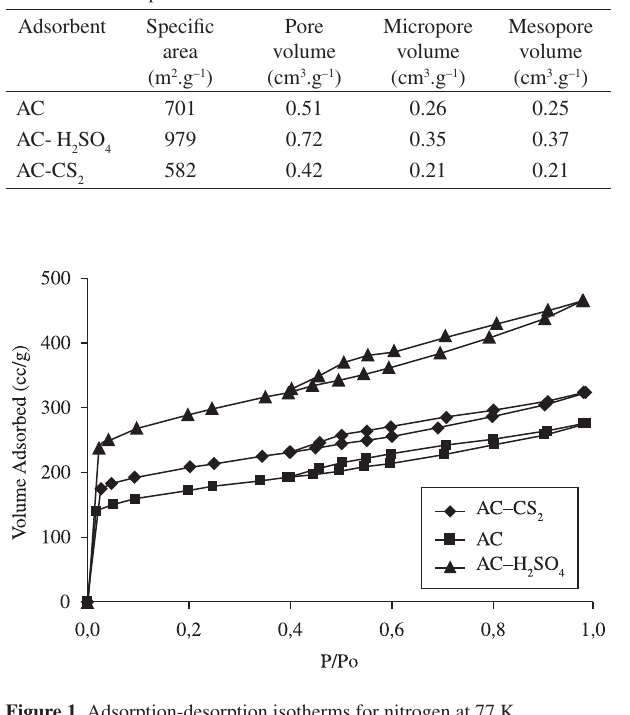
Figure 1. Adsorption-desorption isotherms for nitrogen at 77 K.